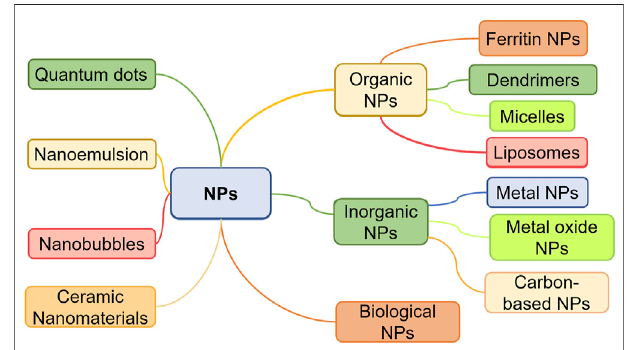
FIGURE 1 | Nanoparticle classi fi